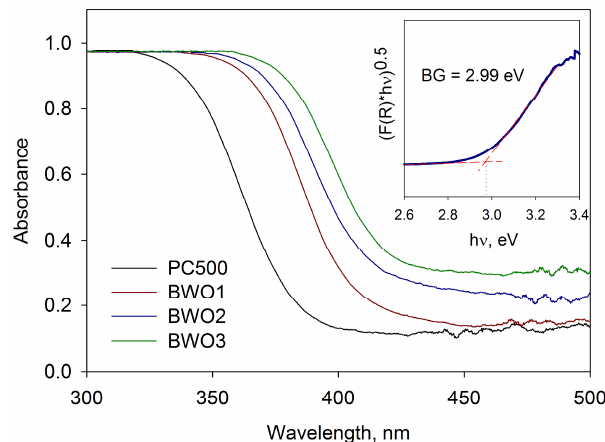
Figure 4. UV ‐ visible absorbance spectra of bismuth tungstate ‐ coated and uncoated titania particles. Insert shows calculation of the band gap with Tauc plot on the example of sample BWO3 (BG = 2.99 eV).